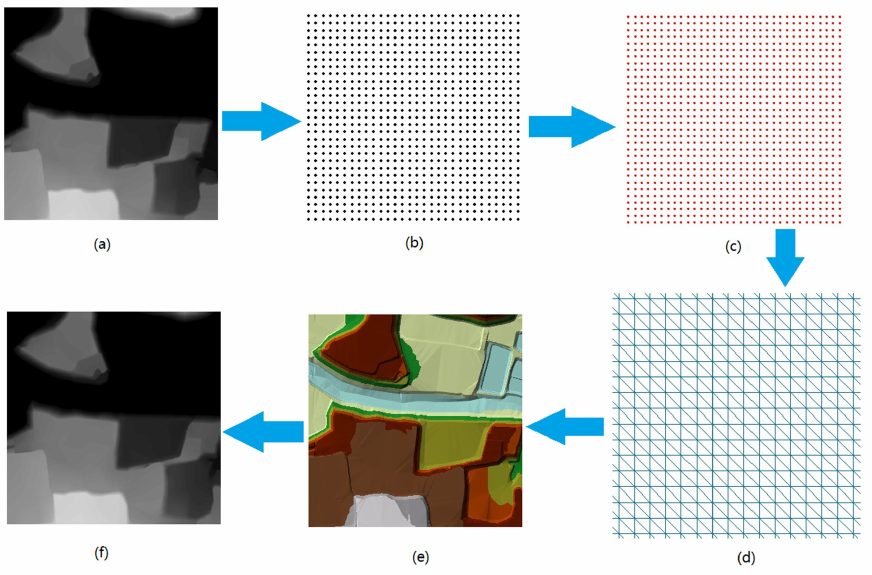
Figure 1. The process of large scale DEM data coordinate transformation. (a) Source DEM; (b) Discrete elevation points (c) Elevation points after adjustment; (d) Delaunay triangulation; (e) TIN after rendering ; (f) Target